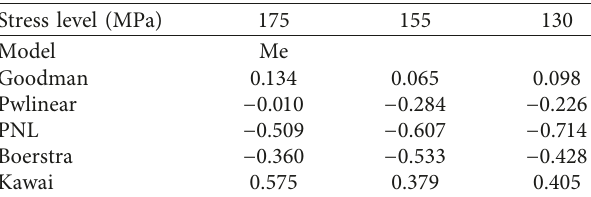
Figure 11: The life prediction results of each model: (a) 2/1 laminate; (b) 3/2 laminate. Table 3: Comparison of model prediction results for the 2/1 laminates under spectrum loading.